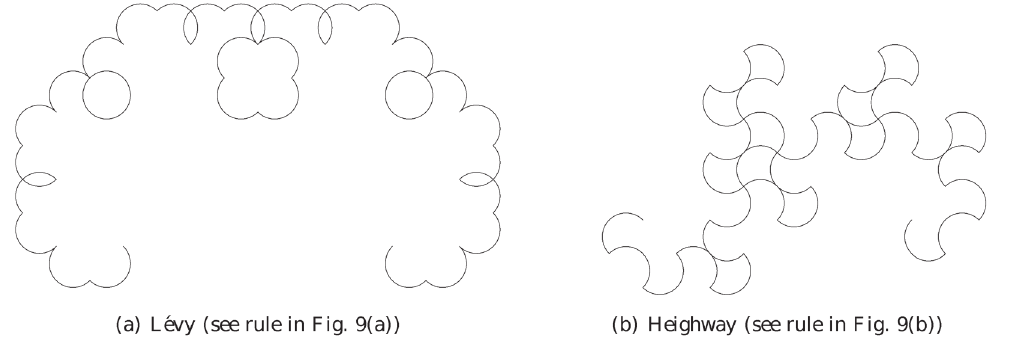
Fig 11. 2-arc fractals at level